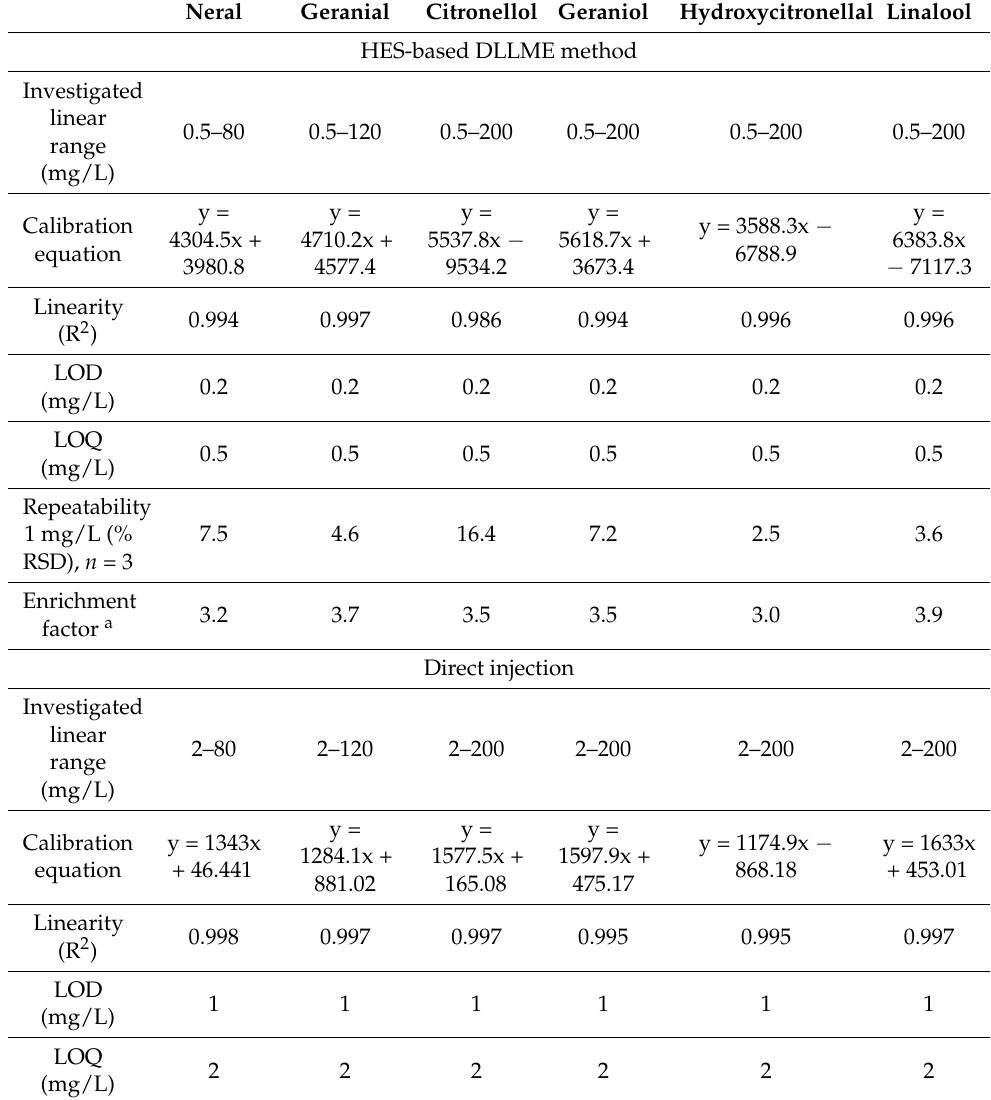
Table 2. Analytical figures of merit for the target suspected cosmetic allergens using the HES-based DLLME GC-FID method and direct injection GC-FID